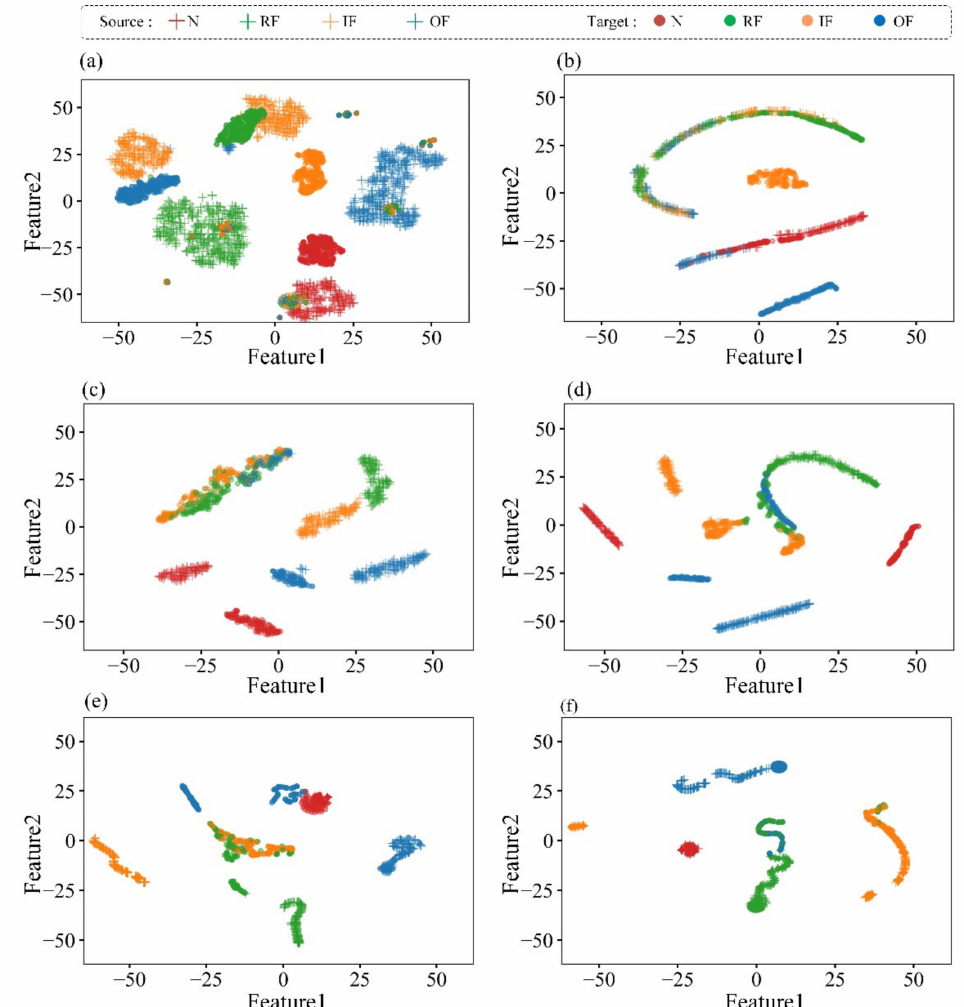
Figure 8. T-SNE visualization results of E → F on the six methods, where ( a ) WEF-SVM, ( b ) ADDA, ( c ) DDC, ( d ) DANN, ( e ) TADA and ( f ) the proposed